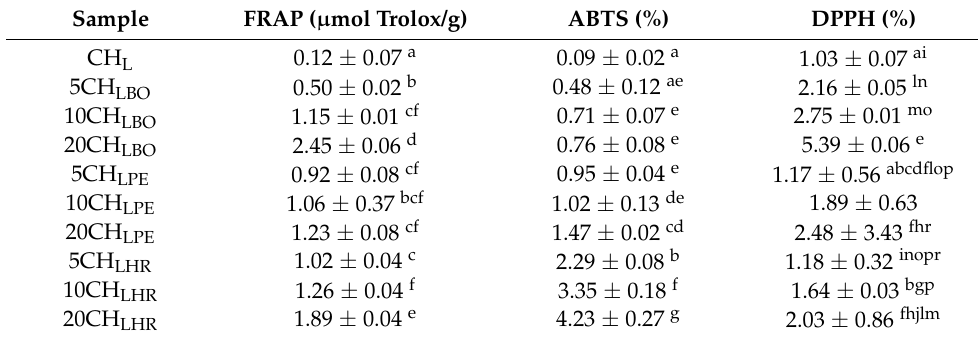
Table 10. Antioxidant properties of chitosan